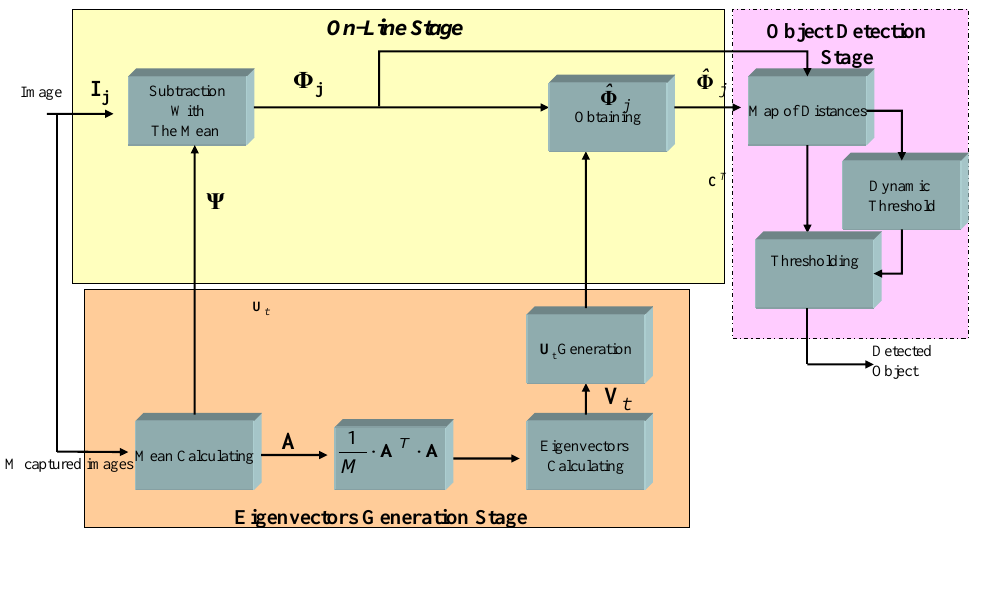
Figure 2. Block diagram of the PCA algorithm implemented on an